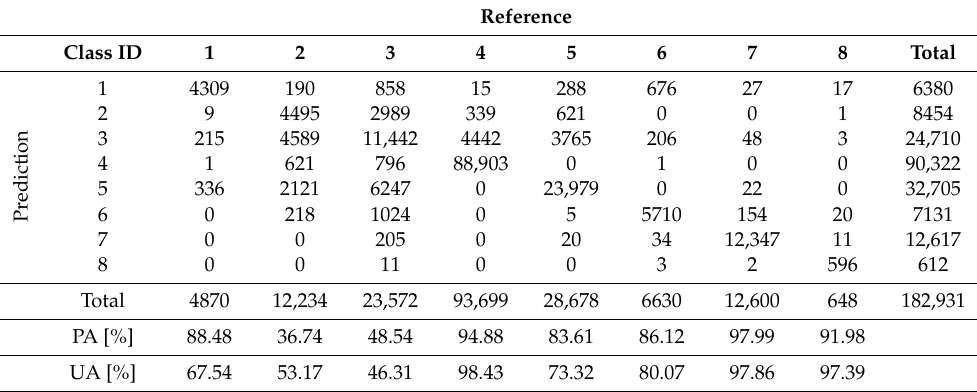
Table A6. Confusion matrix after the 5-fold LLOCV using the MC rule and 5 × 5 neighborhood for